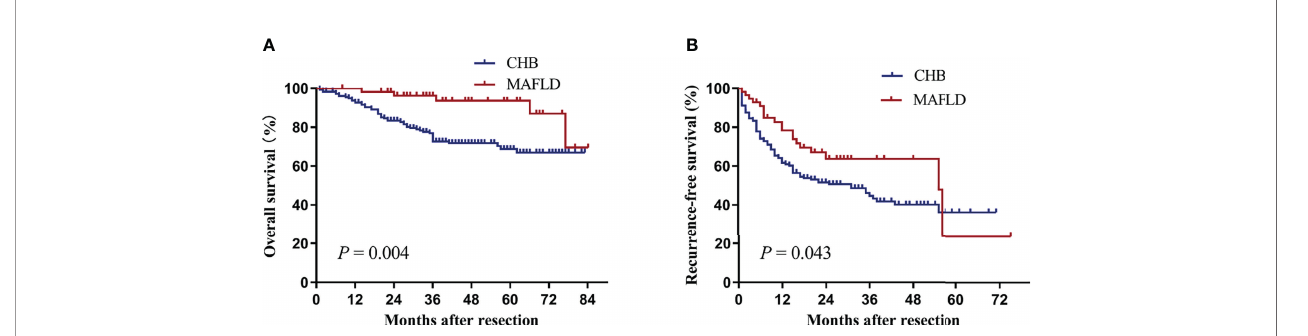
FIGURE 3 | Kaplan – Meier analysis of overall (A) and recurrence-free survival (B) for the MAFLD and CHB counterparts after propensity score matching. CHB, chronic hepatitis B; MAFLD, metabolic dysfunction-associated fatty